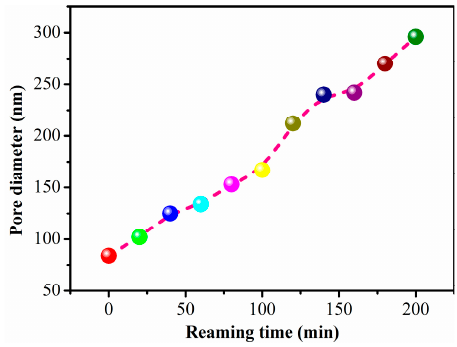
Figure 5. Curve correlating the mean pore diameter with etching time.